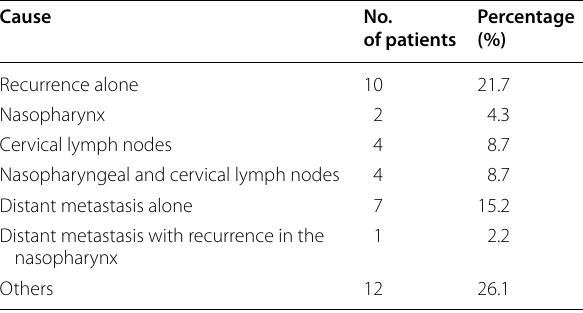
Table 2 Causes of death for the 46 NPC